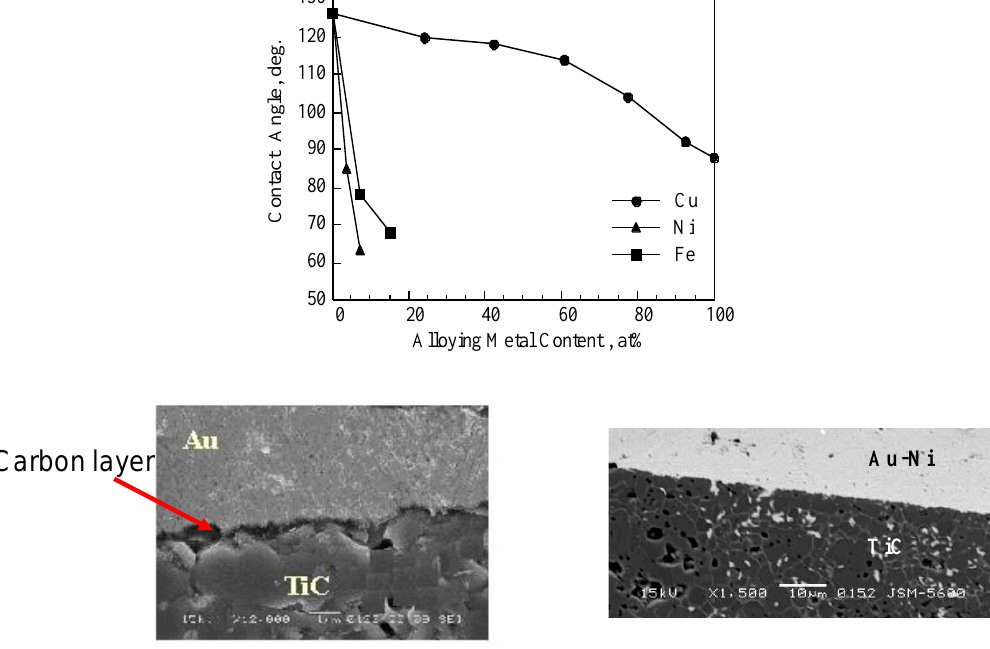
Figure 7. Top : Contact angle between TiC and Au alloys at 1150 °C. Bottom : Metal/TiC Fig. 7 - Top: Contact angle between TiC and Au alloys at 1150°C. Bottom: Metal/TiC interfaces for pure Au and an interfaces for pure Au and an Au-Ni alloy Au-Ni alloy [12].